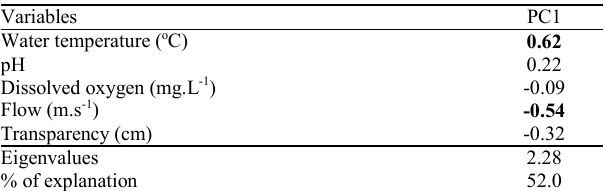
Table 3. Correlations of environmental variables with Principal Component 1 (PC1), eigenvalue and the respective percentage of explanation. Values greater than 0.4 are in bold.